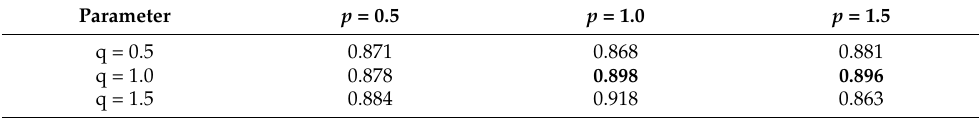
Table 5. Experimental results for different parameter settings on CA-GrQc dataset.